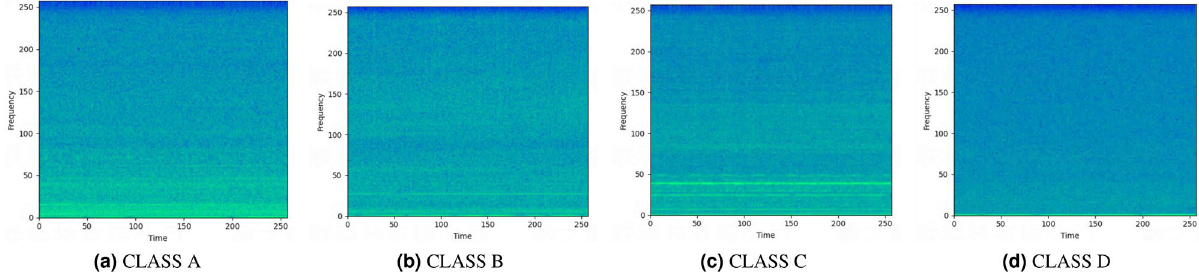
Figure 4. Time-Frequency Representation of each category.